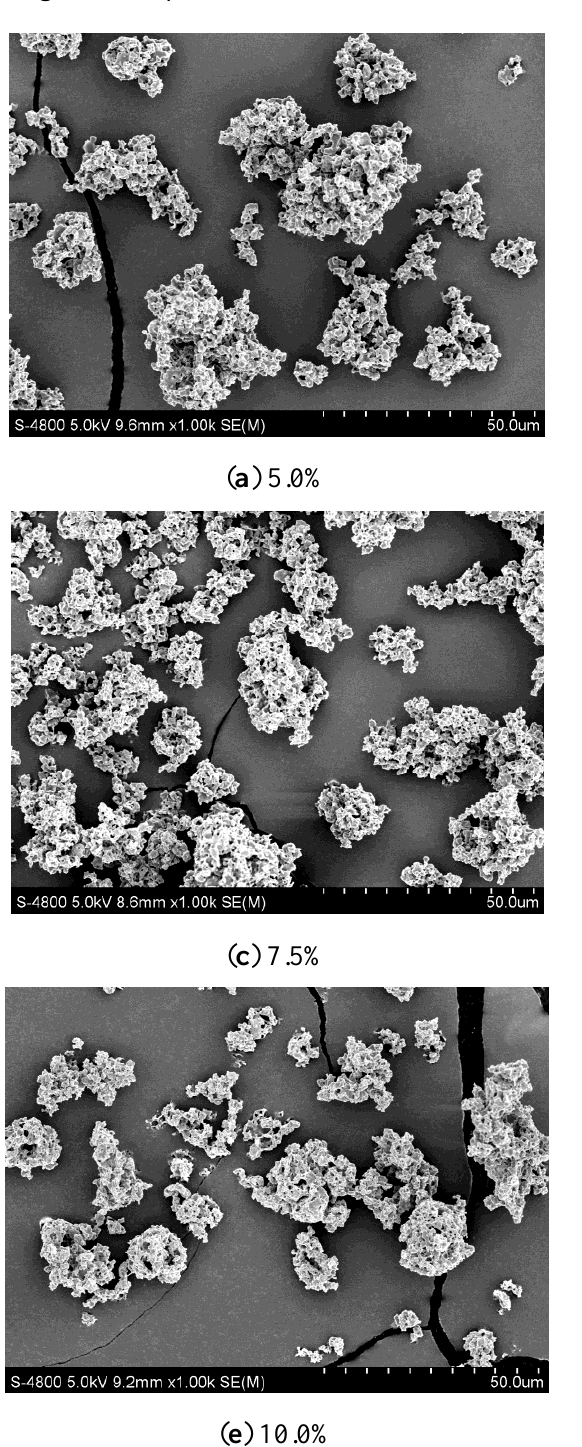
Figure 2. SEM images of LSZ-PLLA PMs of different drug loads (DLs) and their geometric particle size distributions.